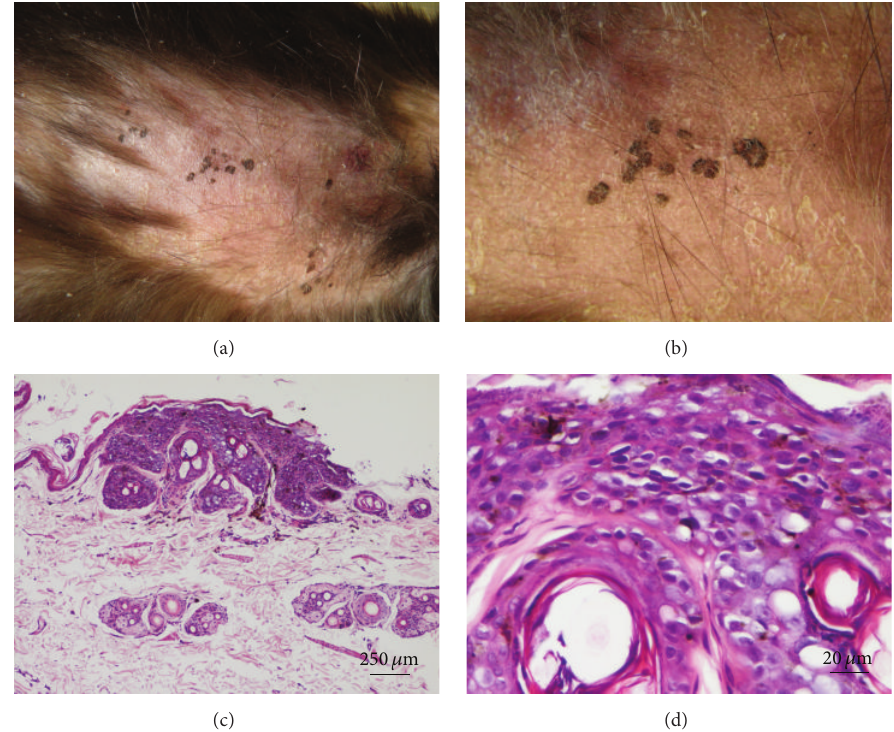
Figure 1: Macroscopic and microscopic features. Ill-defined alopecia in the cat trunk with multifocally grouped, 2 to 8mm, pigmented, slightly raised, nonulcerated plaques (a). Detail of plaques arising from the alopecic and exfoliating skin (b): plaques have a rough surface and an irregular shape. Focal hyperplasia and dysplasia of the surface and follicular epidermis accompanied by mildly asynchronous keratinocyte maturation; note the loosely arranged and slightly fragmented collagen fibers in the dermis (c). Detail of (c): some keratinocytes have dark condensed nuclei and a clear cytoplasmic halo (koilocytes); others have a blue-grey cytoplasm (hematoxylin and eosin